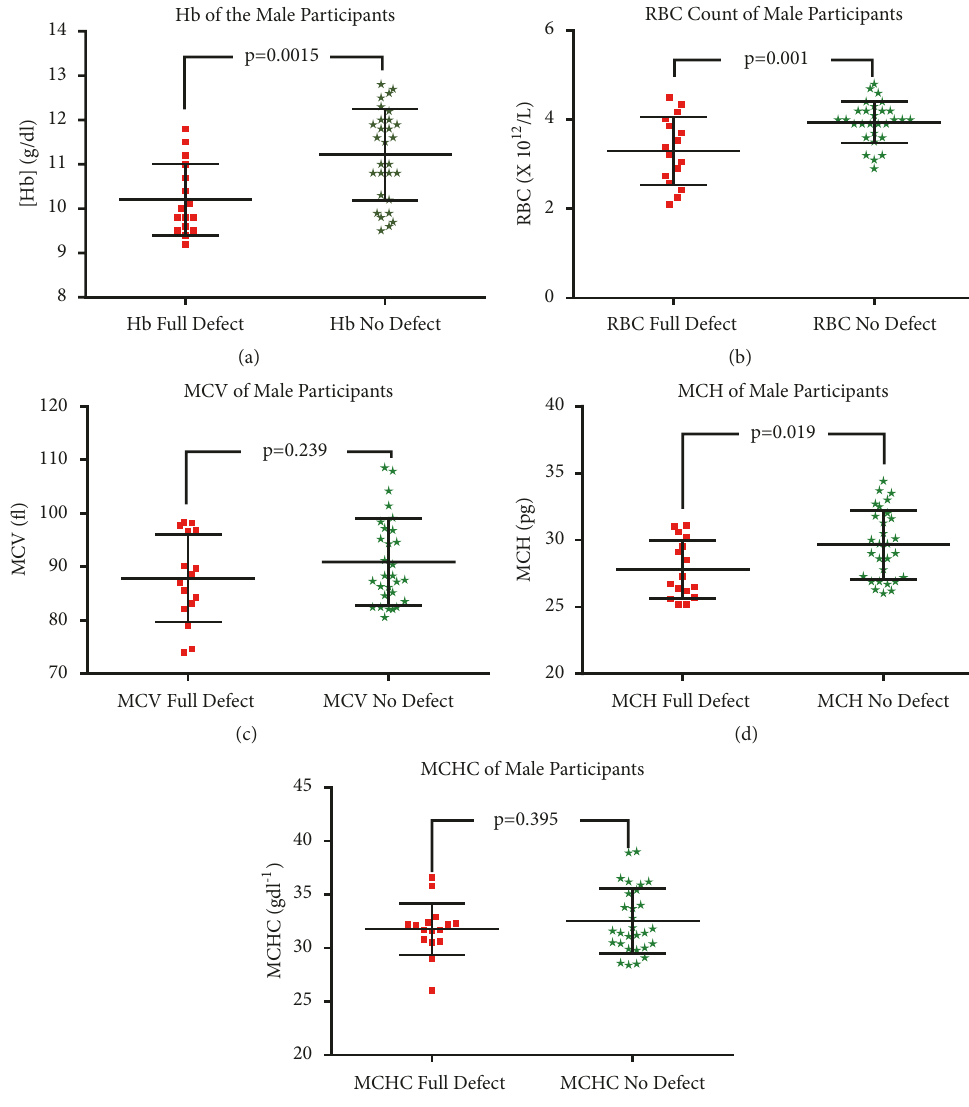
Figure 4: The figure represents comparison of RBC indices and G6PD status of male participants.